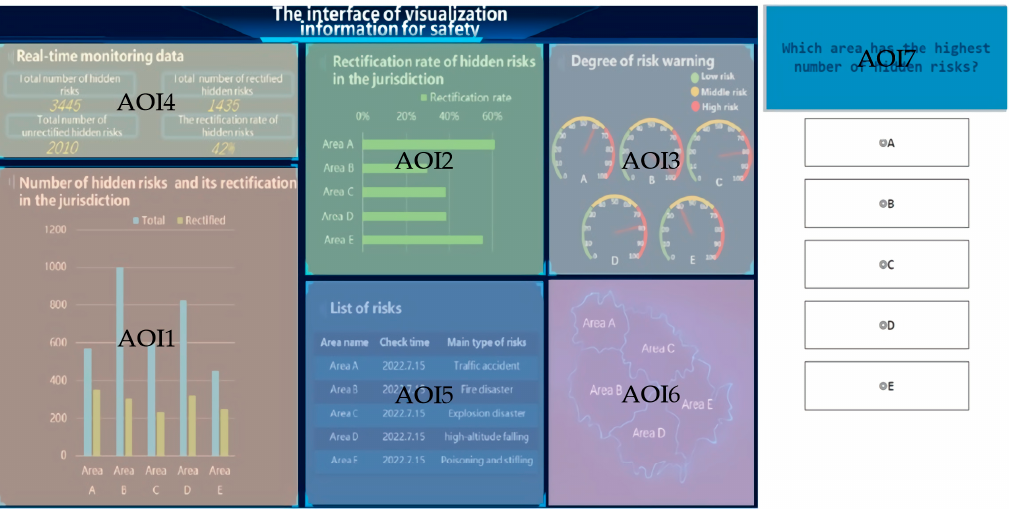
Figure 12. Interface AOI division.